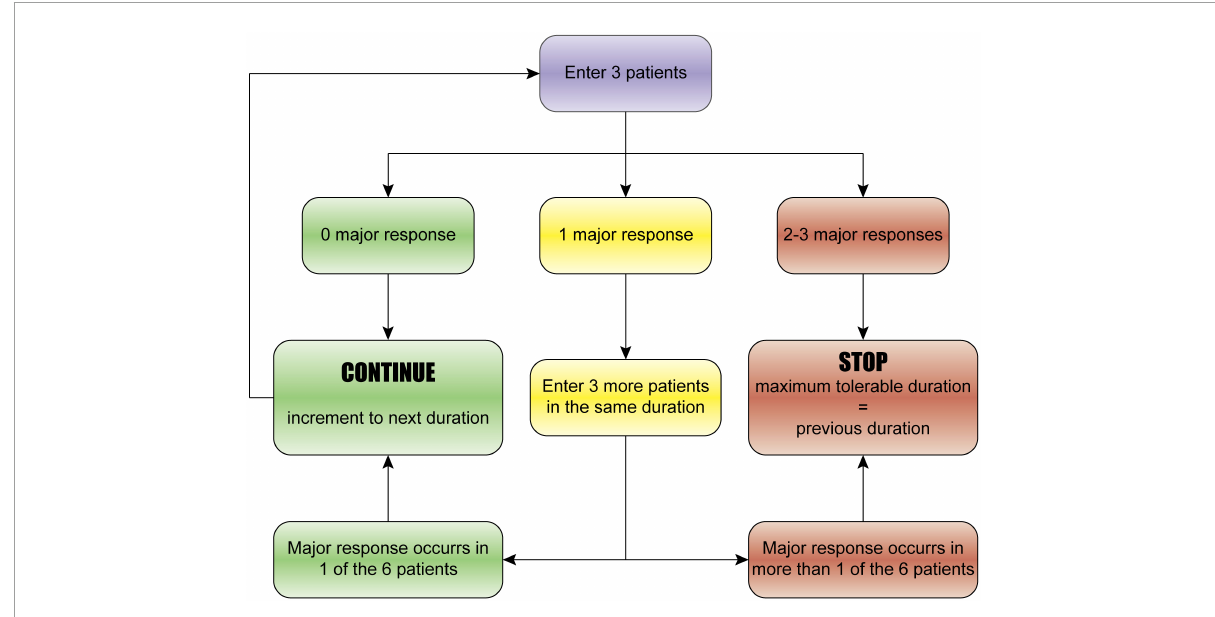
FIGURE1 The 3 + 3 dose-escalation trial design. The study starts with three patients. (a) If no major response occurs in any of the three patients, the next duration will be used. (b) If a major response occurs in one patient, then three more patients will be enrolled to further assess the safety and tolerability of the same duration; if no additional major response occurs, the duration will be escalated to the next dose; if an additional major response occurs, the study will be stopped, and the previous dose will be defined as the maximum tolerable duration of ischemic post-conditioning. (c) If a major response happens in 2–3 patients, the study will be stopped, and the previous dose will be defined as the maximum tolerable duration. The incremental schedule of the duration is 0, 1, 2, 3, 4, and 5 min × 4